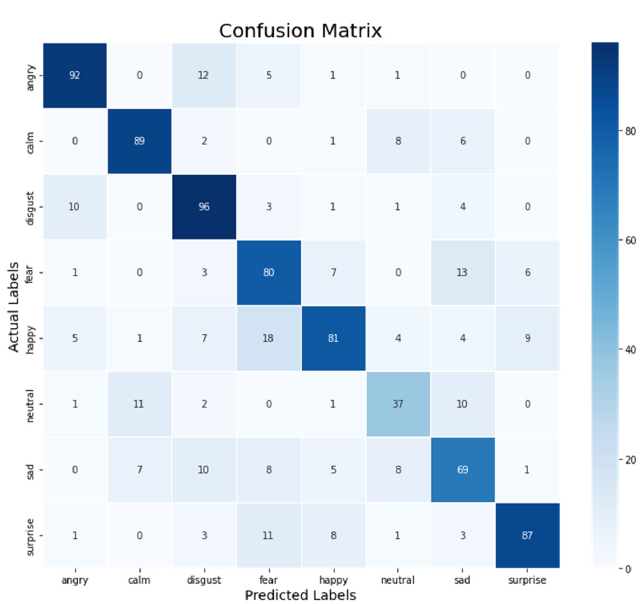
Figure 6 represents the plot of the confusion matrix for eight emotion categories that included sad, calm, fear, surprise, angry, happy, neutral, and disgust.